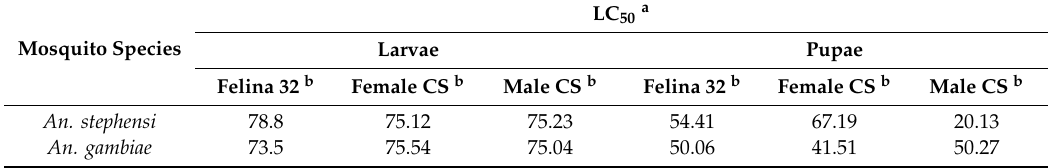
Table 2. LC 50 values of essential oils from monoecious, male, and female inflorescences of hemp, cv Felina 32 and Carmagnola CS against larvae and pupae of An. stephensi and An. gambiae . Mosquito Species